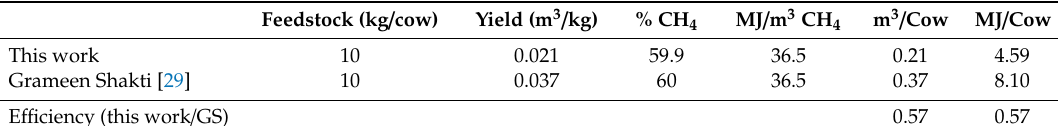
Table 5. Daily Biogas Yield per Cow (Reproduced with permission from Gofran, 2008). Feedstock (kg /